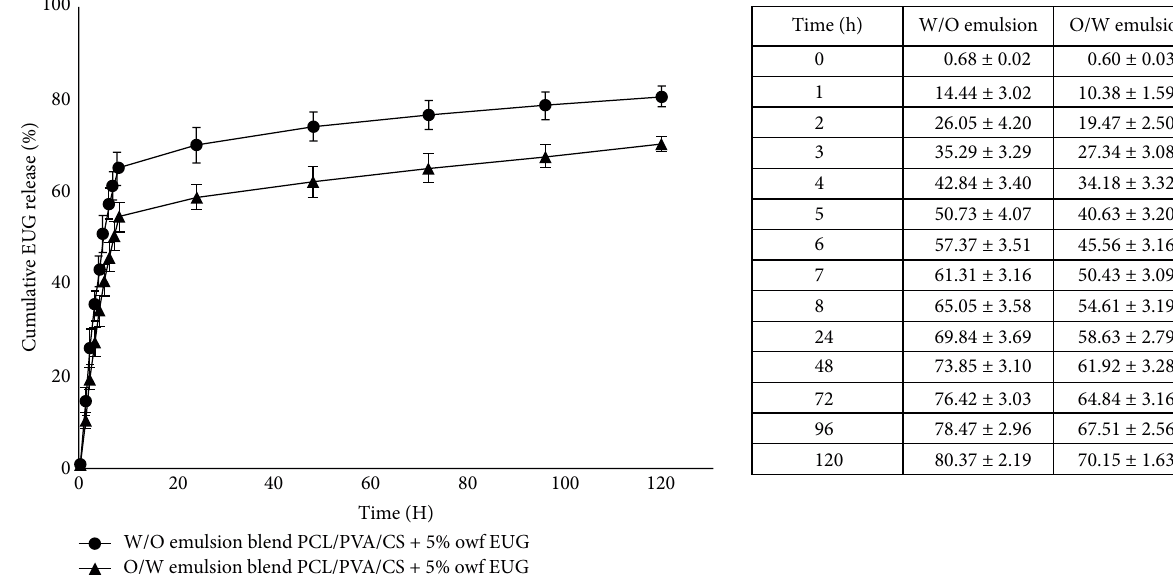
Figure 4: In vitro release study of EUG loaded into electrospun PCL/PVA/CS fiber mats at a physiological pH of 7.4 in a PBS buffer solution for 120